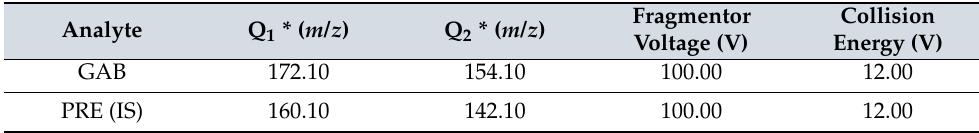
Table 1. MS/MS factors optimised for the evaluation of GAB and PRE,